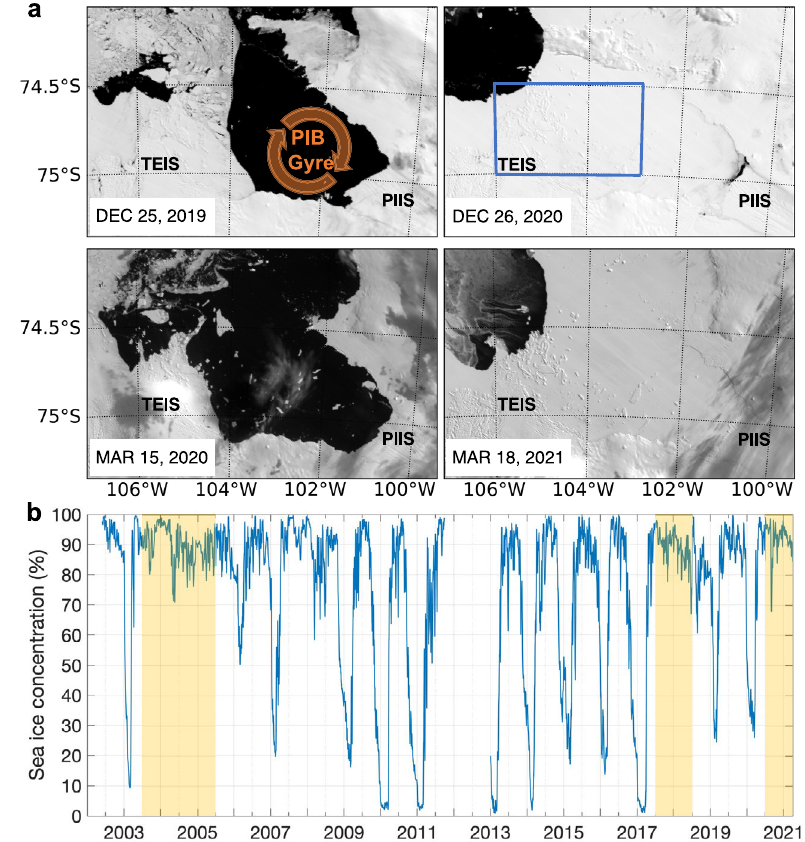
Fig. 9 | Sea-ice concentration during the study period. a Terra MODIS optical imagery shows the sea-ice coverage in Pine Island Bay (PIB) during two dates in thecyclonicPIBgyreisshowninupperleftpanel.Bluepolygoninupperrightpanel delimits the area where the sea-ice concentration was estimated for panel b.